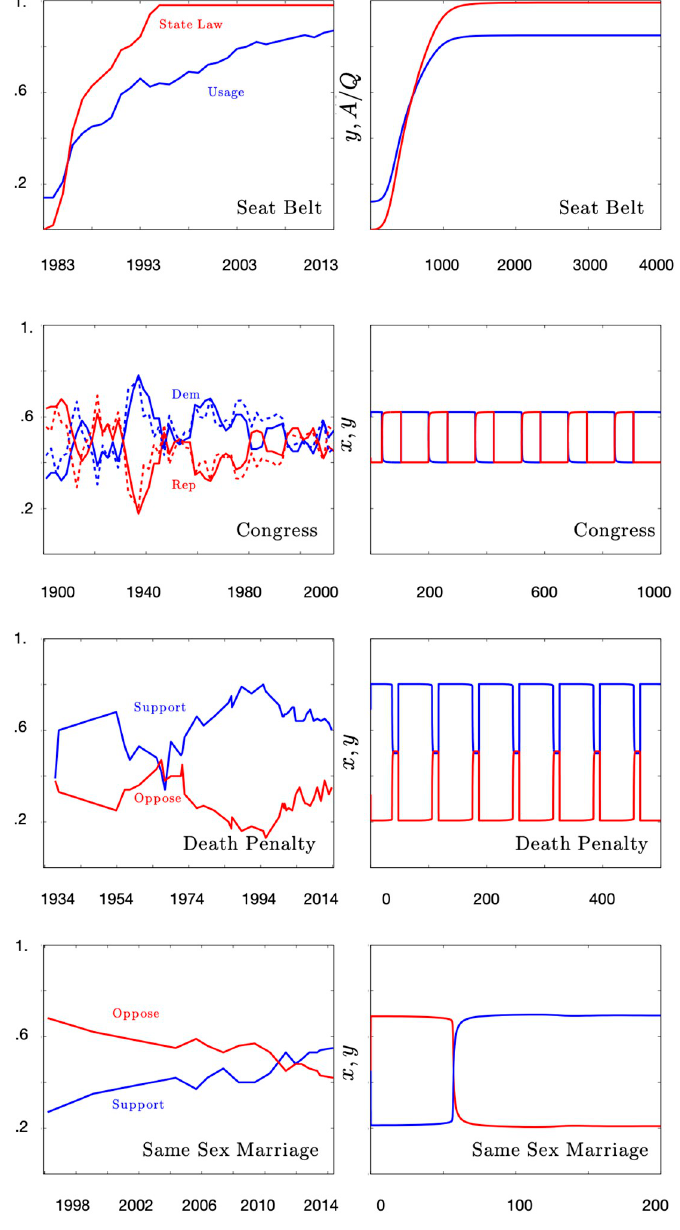
Fig 3. (Reading from left (empirical data) to right (simulated model) and top to bottom over the eight panels): Seat belt usage and number of states that have seat belt legislation paired with simulated results of model with fitted parameter values; Ratio of the US senate (solid line) and house (dotted line) seats for the Democrats and the Republicans and simulated model; Support and opposition of same-sex marriage and simulated model; Support and opposition of the death penalty and simulated model. Parameter values are provided in S2 File. In all of these cases the model is easily able to recover the qualitative features of the time